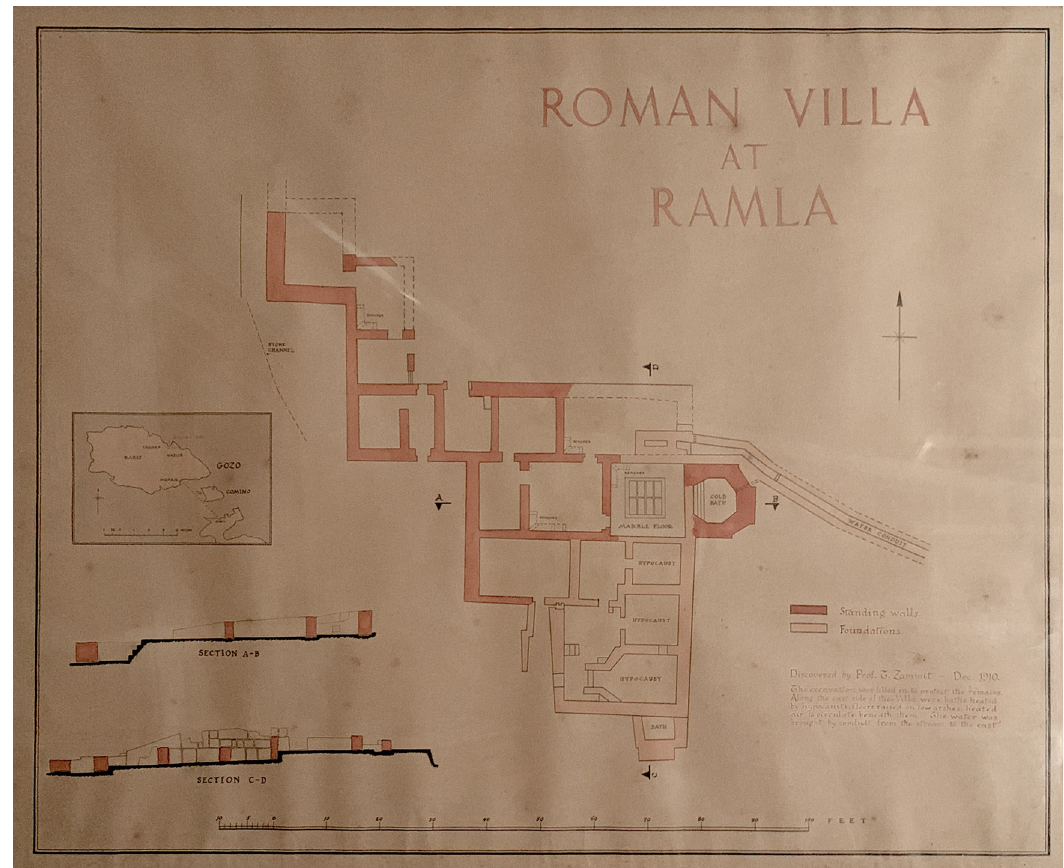
Figure 2: Plan conserved at the National Museum of Archaeology, Malta of the villa remains at Ramla l - Ħ amra Bay, Gozo ( Source: NMA )